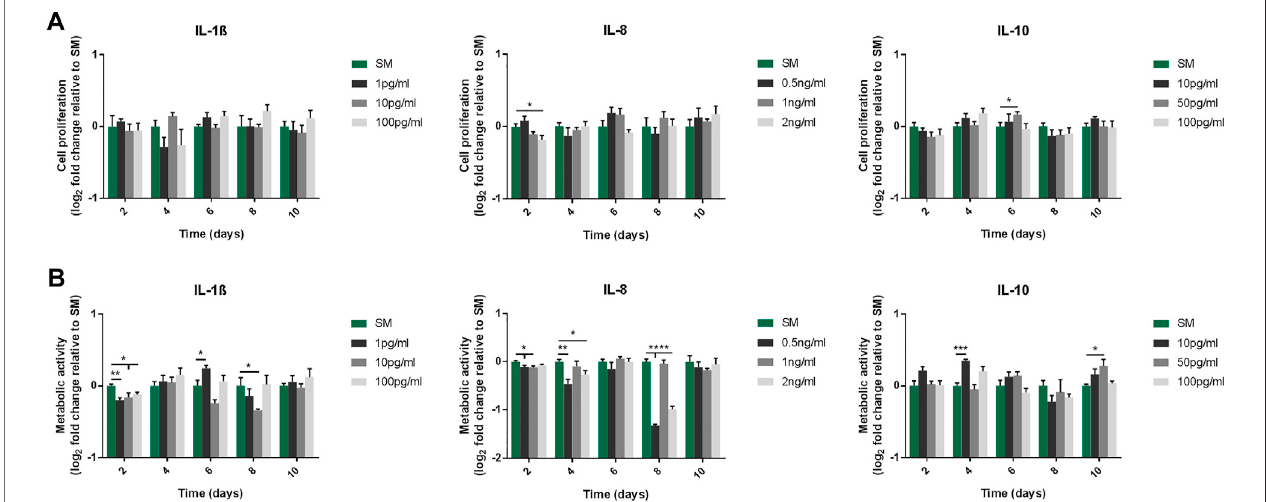
FIGURE 1 | Proliferative capacity (A) and metabolic activity (B) of MSC cultures following exposure to IL-1 β , IL-8 and IL-10 for 10 days. (A) Proliferative capacity measuredbycellcounts. Dosesused were1/10/100 pg/mlforIL-1 β , 0.5/1/2 ng/mlforIL-8, and 10/50/100 pg/mlfor IL-10.Datashown aslog 2 foldchangecompared to SM control condition. Error bars represent SEM. n = 4, * p < 0.05, ** p < 0.01, *** p < 0.001, **** p < 0.0001.